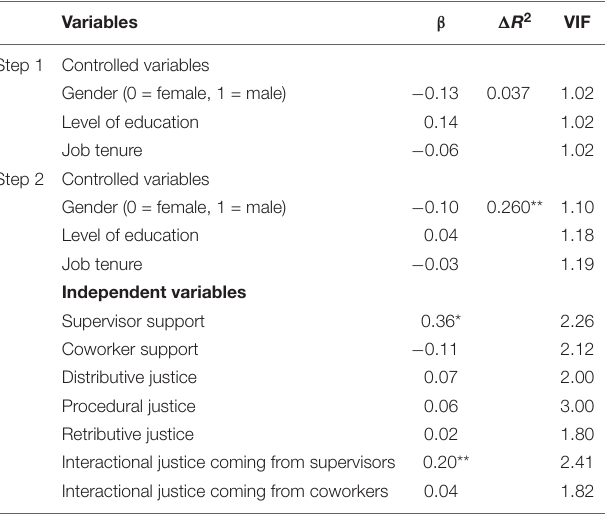
TABLE 3 | Regression results for the effect of gender, level of education, job tenure, organizational support, and organizational justice on work engagement. Variables β